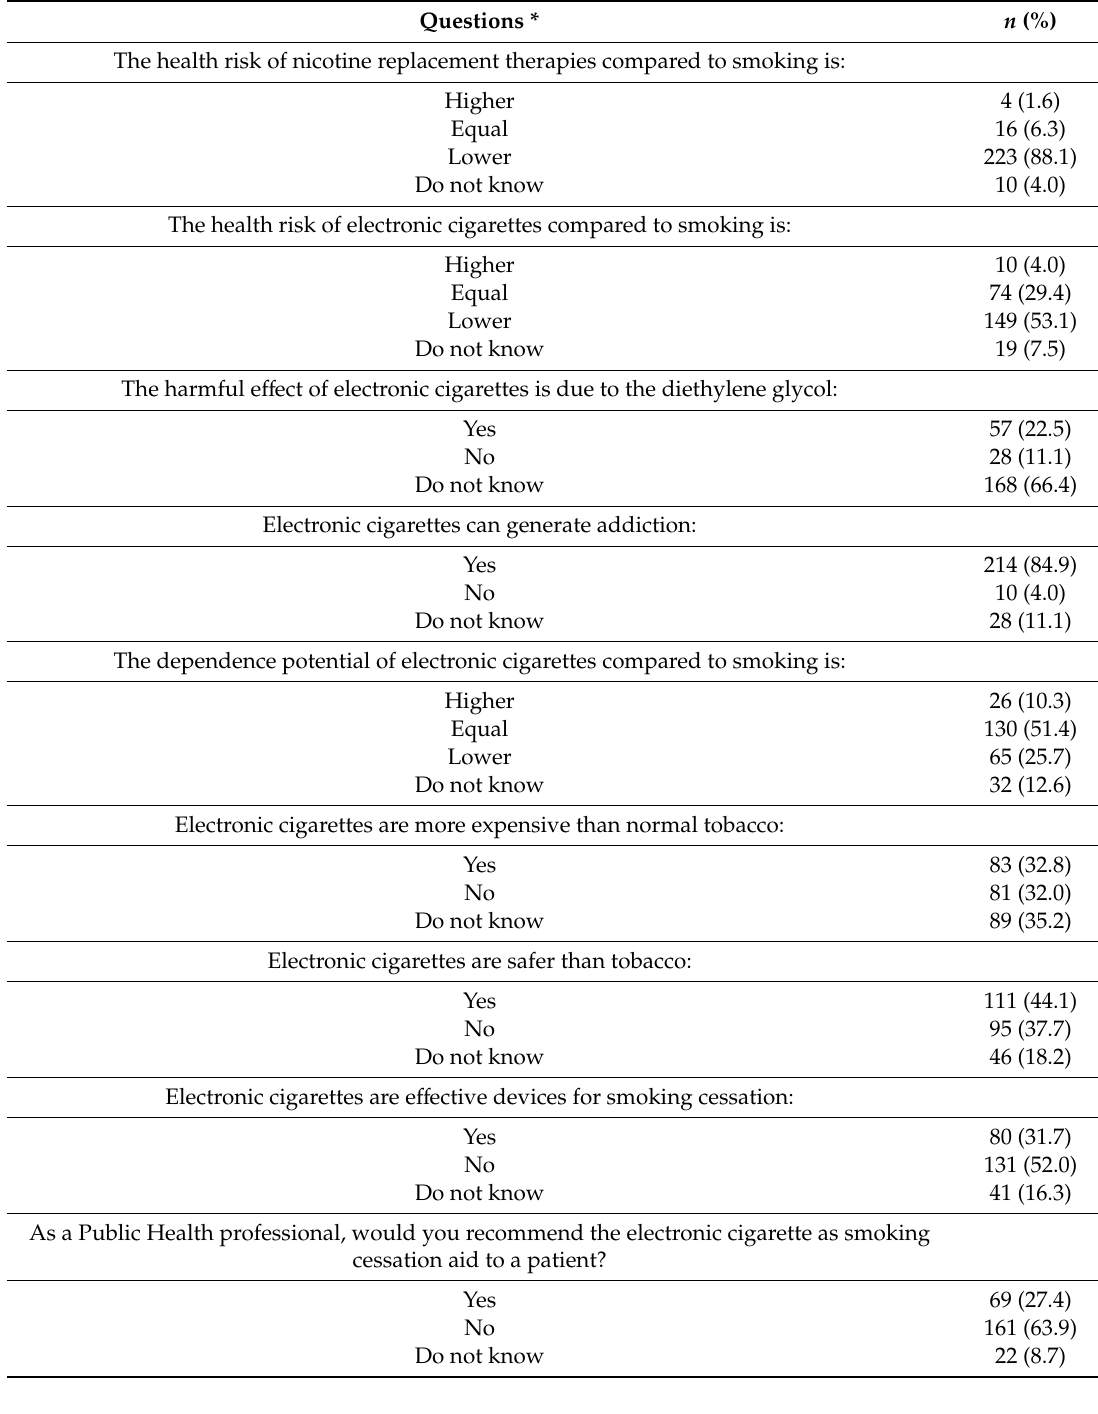
Table 2. Participants’ responses on e-cigarettes and tobacco harm